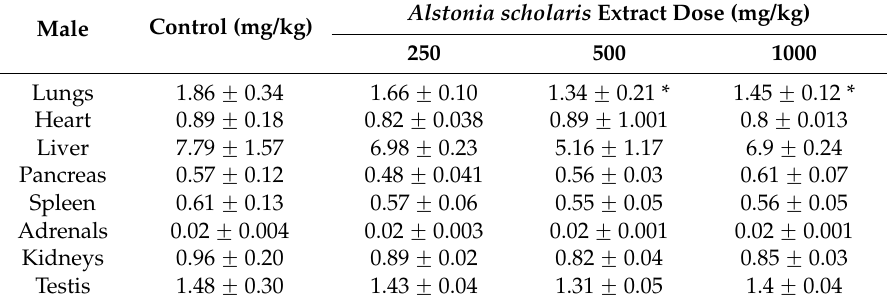
urea, uric acid, calcium and phosphate concentrations in the treated groups were not significantly